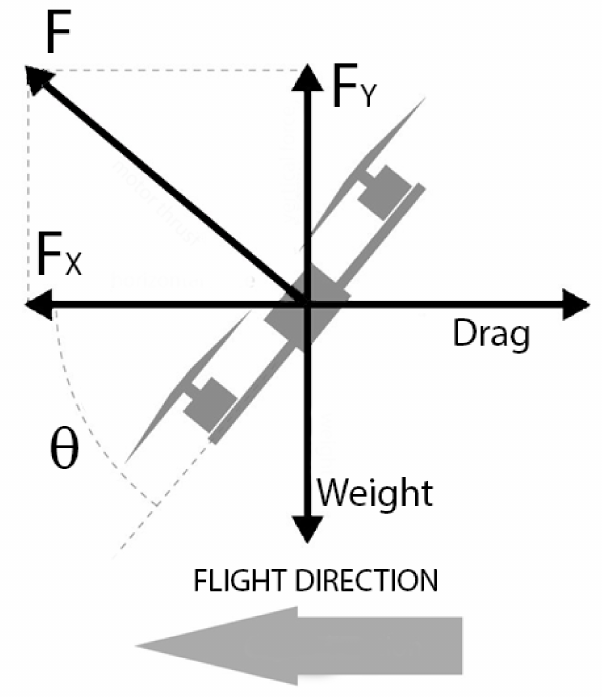
Figure 1. Steady state flight condition of a multicopter